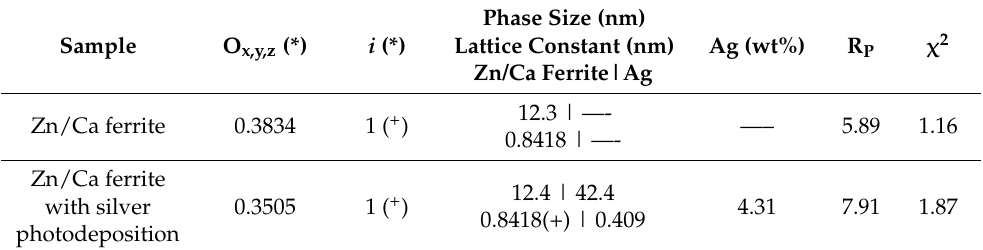
Table 1. Selected parameters from the Rietveld analysis using BGMN.